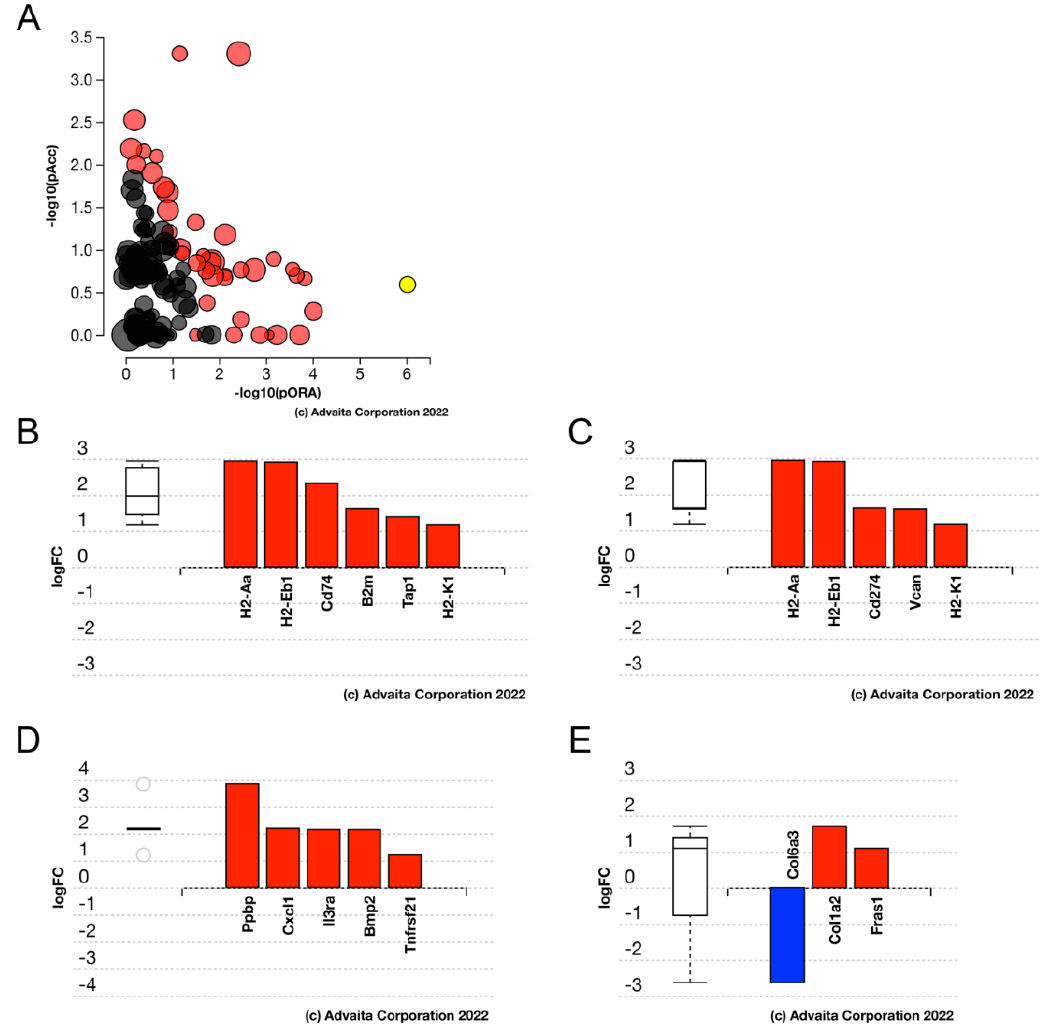
Figure 7. Advaita iPathway analysis of differentially expressed pathways/genes between 6 h Egr1KO and 6 h WT LECs. ( A ) Impact analysis of the DEGs suggest that the KEGG pathway map “antigen processing and presentation” ( p -value = 4.147 × 10 − 6 ) (yellow dot) is the most significantly impacted pathway in the 6 h LECs. Other impacted KEGG pathways are represented by the other dots with black dots being non-significant KEGG pathways and red dots being significant KEGG pathways. ( B ) Bar graph showing the antigen processing and presentation genes that are differentially expressed in the 6H Egr1KO LECs. ( C ) Bar graph showing the cell adhesion molecules ( p -value = 0.003) pathway of genes differentially expressed in the 6H Egr1KO LECs. ( D ) Bar graph showing the cytokine-cytokine receptor interaction ( p -value = 0.003) pathway of genes differentially expressed in the 6H Egr1KO LECs. ( E ) Bar graph showing the ECM receptor interaction ( p -value = 0.045) pathway of genes differentially expressed in the 6H Egr1KO